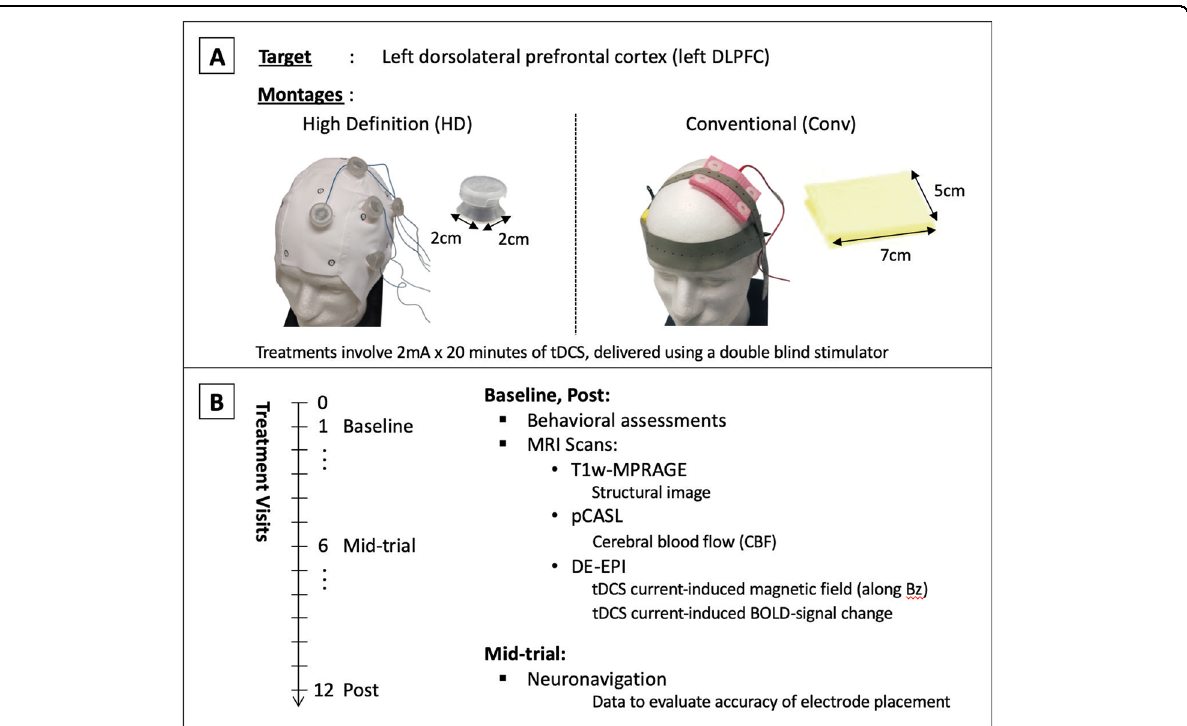
Fig. 2 tDCS stimulation parameters and data acquisition protocol. A Shows the high-de fi nition (HD) and conventional (Conv) tDCS montages utilized in the study. The HD montage consists of a central anode electrode delivering 2 mA at the stimulation target, with four return electrodes placed 5 cm away and equidistant from each other. The Conv montage consists of a 7 × 5 cm electrode placed on the stimulation target, with the return electrode placed at [ x = 56, y = 30, z = − 1] MNI coordinates (~F8). The stimulation target was selected to be [ x = − 46, y = 44, z = 38] MNI coordinates, and electrode placement was performed as detailed in Supplementary material S3. B Shows the data acquisition protocol over treatment visits for each participant. Visit 0 was the consult visit, where a T1w-MPRAGE MRI was acquired to guide electrode placement. Behavioral and MR-imaging data used in analysis were acquired at visits 1 and 12 (baseline and post-treatment, respectively). MRI data included a second structural T1w-MPRAGE scan (used in simulations), followed by a pseudo-continuous arterial spin labeling scan (pCASL, used to calculate cerebral blood fl ow (CBF)), and a dual-echo echo planar imaging scan (DE-EPI, used to calculate (a) the tDCS current-induced magnetic fi eld along the MRI static fi eld (Bz) and (b) the tDCS current-induced BOLD-response). TDCS was delivered during the DE-EPI scan only, which was performed after the pCASL scan to preclude any acute CBF changes resulting from tDCS stimulation. Neuronavigation data was also acquired using Brainsight at the mid- trial visit (visit 6) to quantify the accuracy of electrode-positioning relative to the stimulation